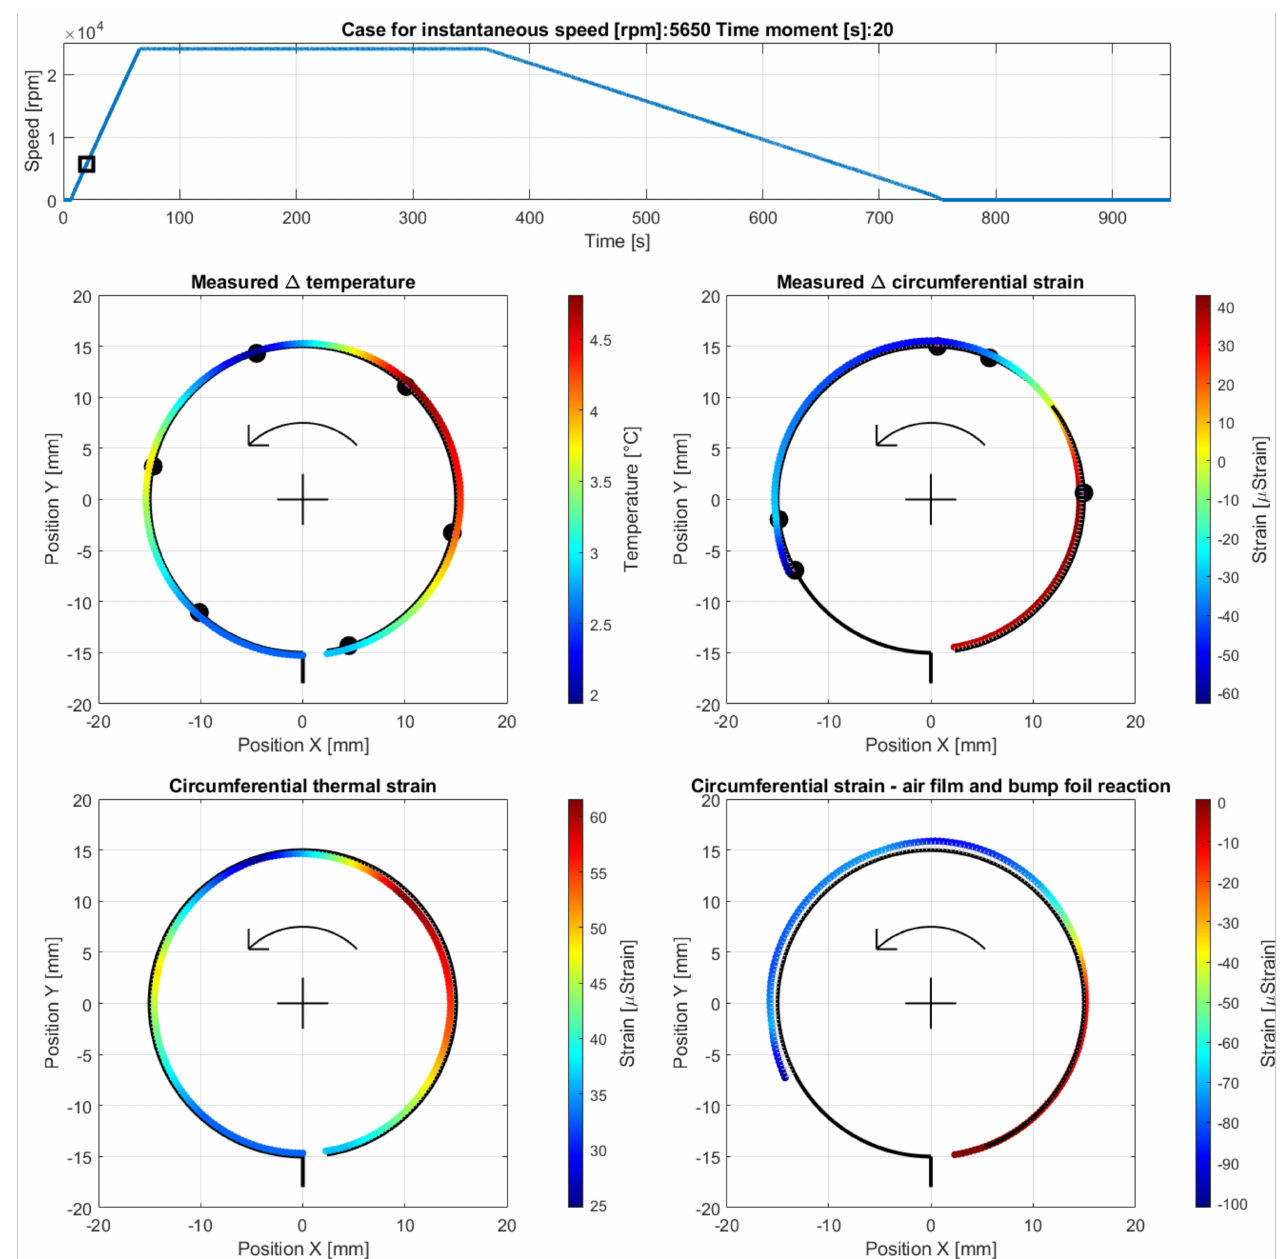
Figure 11. Cross-sectional views for the circumferential distribution of the temperature and strain identified in the top foil at 5650 rpm during the run-up stage of the GFB’s operation. The referential course of the rotational speed is provided on top. Its current value is visualized with a black square marked on the entire speed profile. The arrows indicate the direction of rotation of the shaft. The data presented in the cross-sectional views are explained in the current